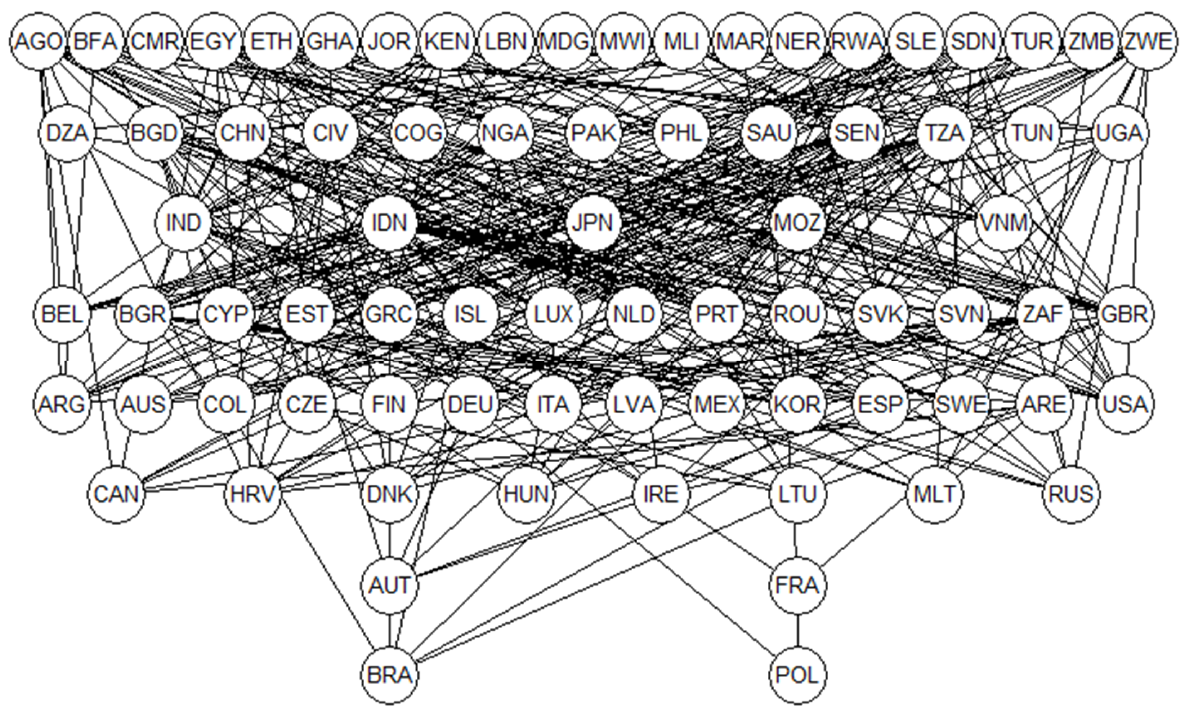
Figure 2. “Input poset” visualized by a Hasse diagram (for details, see text). Immediately, the diagram has a ‘broad’ structure and is highly complex and dominated by a high number of incomparabilities (1955) and a relative low number of comparabilities (1048). Although the number of incomparabilities is very high (around 66% percentage of all possible binary relations), there are nevertheless chains of length 8. By a special program of the software package PyHasse, details about chains can be found. Here, however, a more detailed discussion is out of the scope of the paper. The main point is that the Hasse diagram is complex; however, there are tools to unfold the jungle of lines. In the analog study from 2017 [31], four different weighting schemes were discussed corresponding to the relative weighting of the four indicators by four different stakeholders (Expert, Political, Outcome, and Uniform). The four weight schemes are given in Table